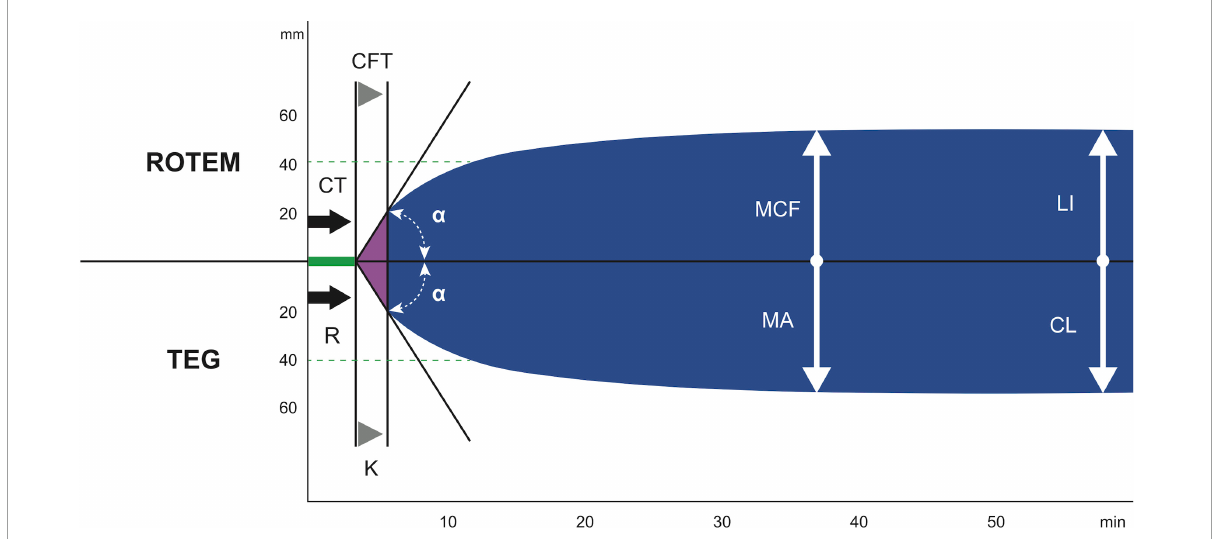
FIGURE1 The difference in the terminology of the most important results between ROTEM and TEG. ROTEM parameters: CT, clotting time; CFT, clot formation time; α , α angle; MCF, maximum clot firmness; LI (30/60), lysis index 30 and 60 min after CT. TEG parameters: R, reaction time; k, kinetics; α , α angle; MA, maximum amplitude; CL (30/60), clot lysis after 30 and 60 min (89). With reprint permission by Georg Thieme Verlag KG.